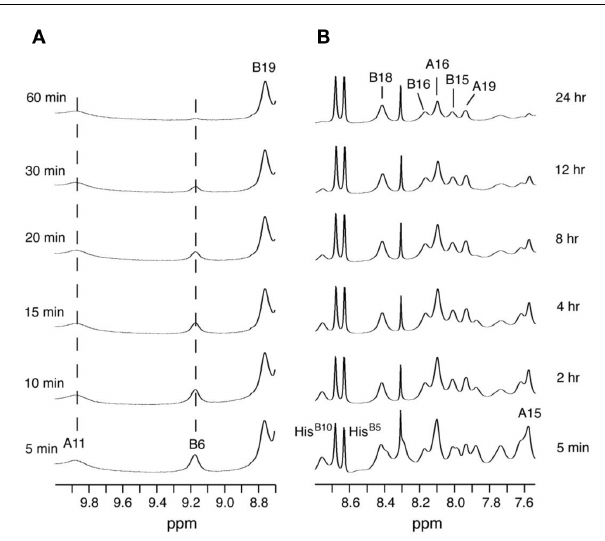
FIGURE 5 | One-dimensional 1 H-NMR studies of amide-proton exchange in D 2 O (pH 3.0 and 25˚C). (A) Spectra of downfield amide region as observed after successive times in D 2 O.Vertical dashed lines indicate the amide protons of Cys A11 (9.86ppm; left) and Leu B6 (9.17ppm; center), which are engaged inT-state-specific inter-chain hydrogen bonds (see text). (B) Spectra of major amide region at corresponding times; selected assignments are as indicated at top.The two sharp downfield resonances between 8.6 and 8.7ppm belong to the H ε ring resonances of His B5 and His B10 ; the sharp resonance at 8.3ppm is an impurity.